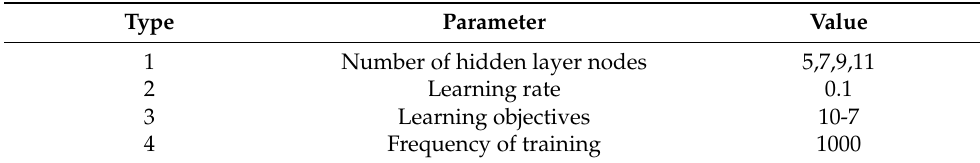
Table 1. Parameter selection of back propagation (BP) neural network.